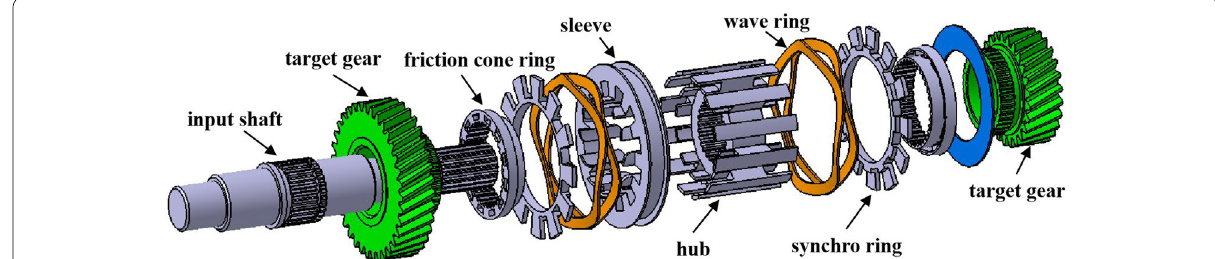
Figure 10 The structure and assembly relationship of